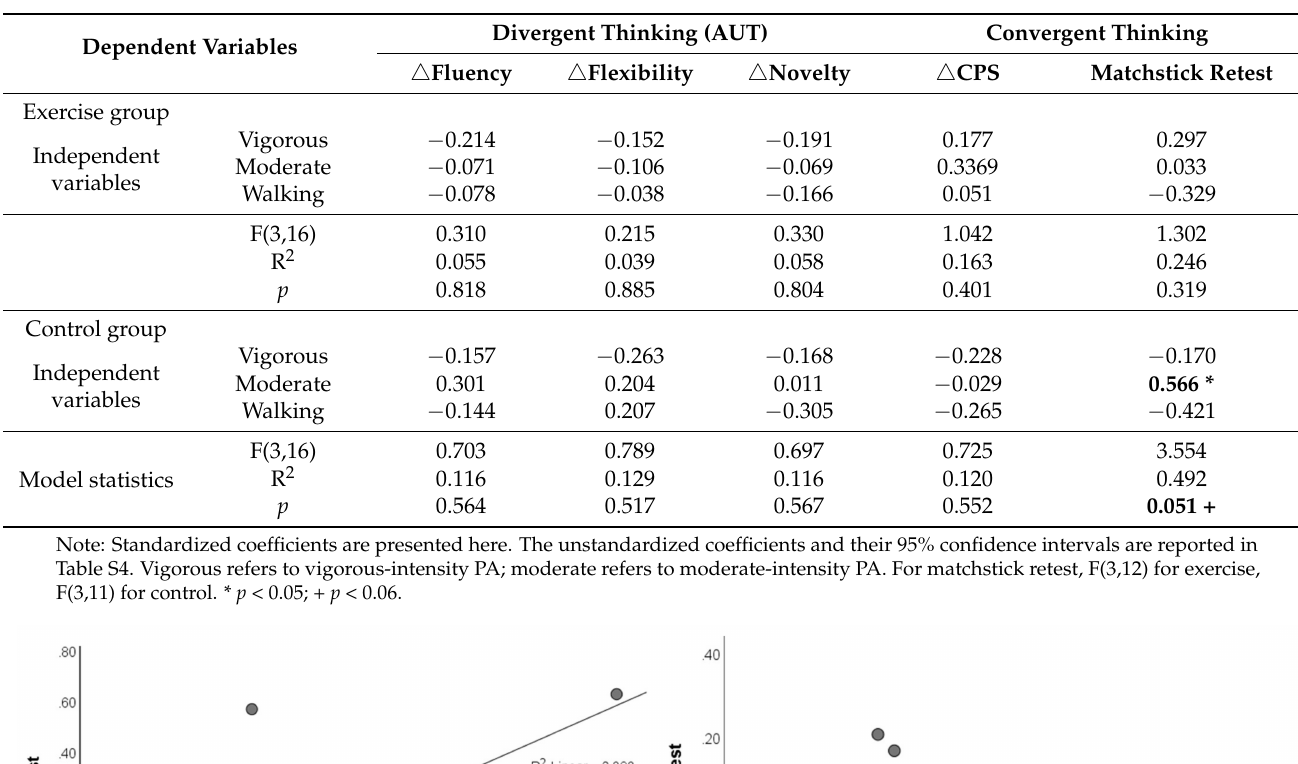
Table 2. Multiple linear regression results using intensity-specific regular PA to predict the intervention effects on creative thinking.